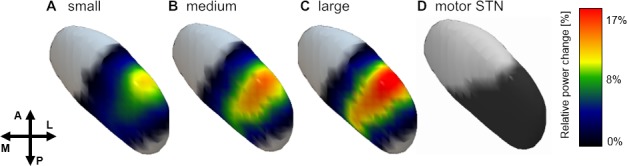
Spatial distribution of gamma power across conditions.Averaged gamma power for small (A), medium (B) and large (C) conditions was spatially interpolated between all contact pairs (left electrodes flipped to right hemisphere) and mapped to the subthalamic surface in standard MNI space. The resulting map revealed a clear peak in the dorsolateral portion of the subthalamic nucleus, which overlapped with the subthalamic motor segment (Ewert et al., 2017) shown in (D). Note the parametric peak size increase with larger movement amplitude.